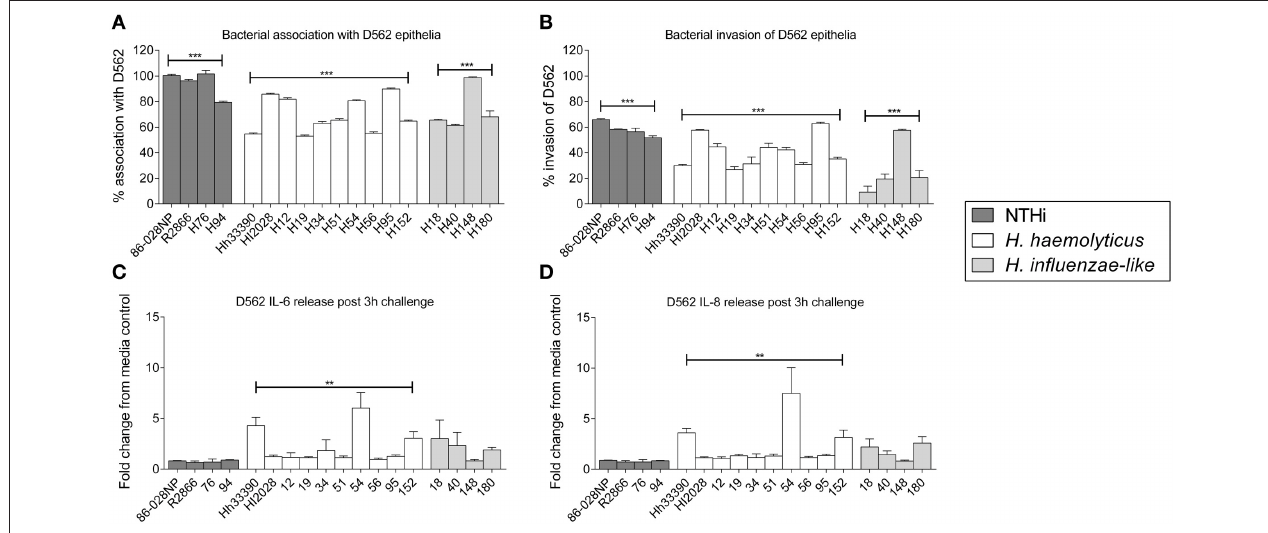
FIGURE 2 | Interactions of clinical strains of haemophili with respiratory epithelia. Association (A) and invasion (B) of D562 epithelial monolayers with haemophilus reference strains and clinical isolates at 3h. Level of IL-6 (C) and IL-8 (D) present in cell culture supernatant at 3h post-bacterial challenge and presented as the fold change of cytokine in the supernatant from cells incubated with media only. Results are represented as the mean ± SEM of three separate experiments, each conducted in triplicate excluding R2866 which was conducted once in triplicate. Kruskal-Wallis and Dunn’s post-test was used to compare intra-species variability where ** p < 0.01 ; *** p < 0.001